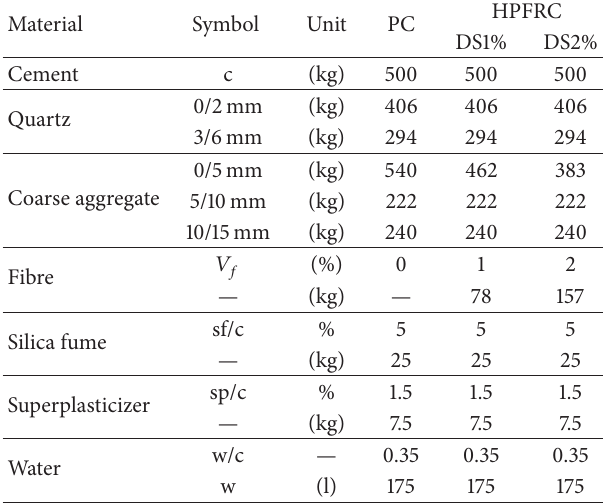
Table 1: Mixture proportions per 1m 3 of PC and HPFRC